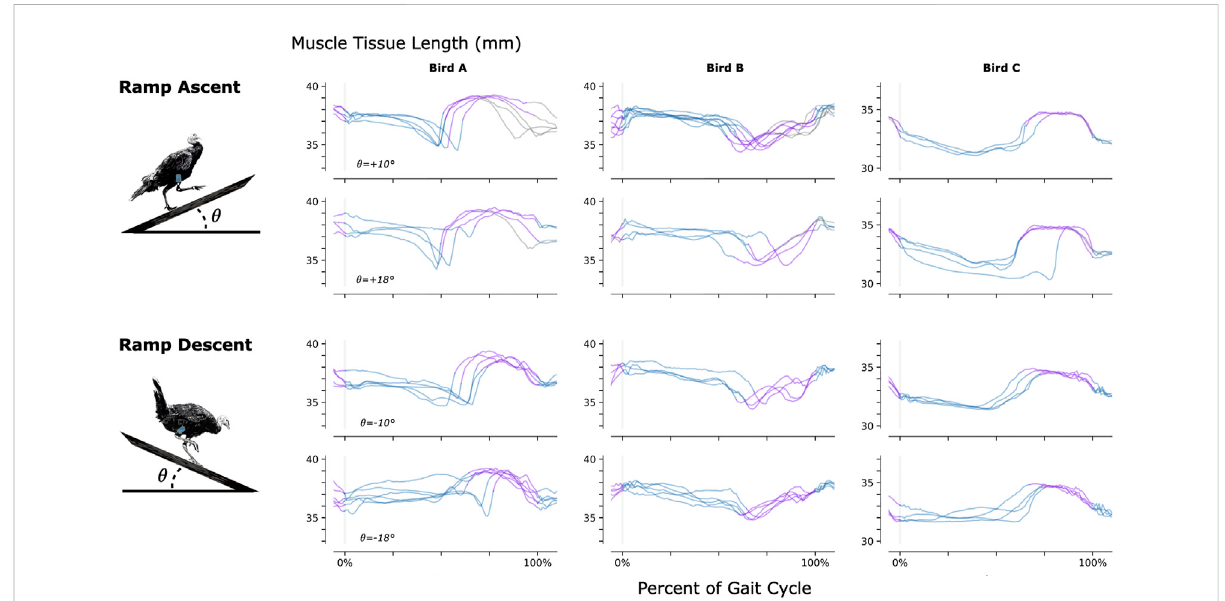
FIGURE 3 Muscle Tissue Length During Non-SynchronousRampAscentand Descent. Weused magnetomicrometryto track muscle tissue length during ramp ascent anddescentattwoinclinesfor all threebirds. Datafor each bird andeach slope are synchronized atrightlegtoe strike (indicated bythe vertical gray line) and normalized from toe strike to toe strike. Variability between curves re fl ects gait cycle variability during untrained ramp navigation. Muscle tissue length is plotted in blue for right leg stance, in purple for right leg swing, and in gray where video did not allow gait- phase labeling. We recorded at least three gait cycles of each activity for each